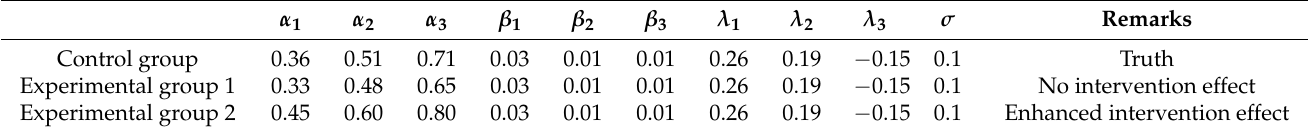
Table 5. Parameter settings considering effects of media on relevant public